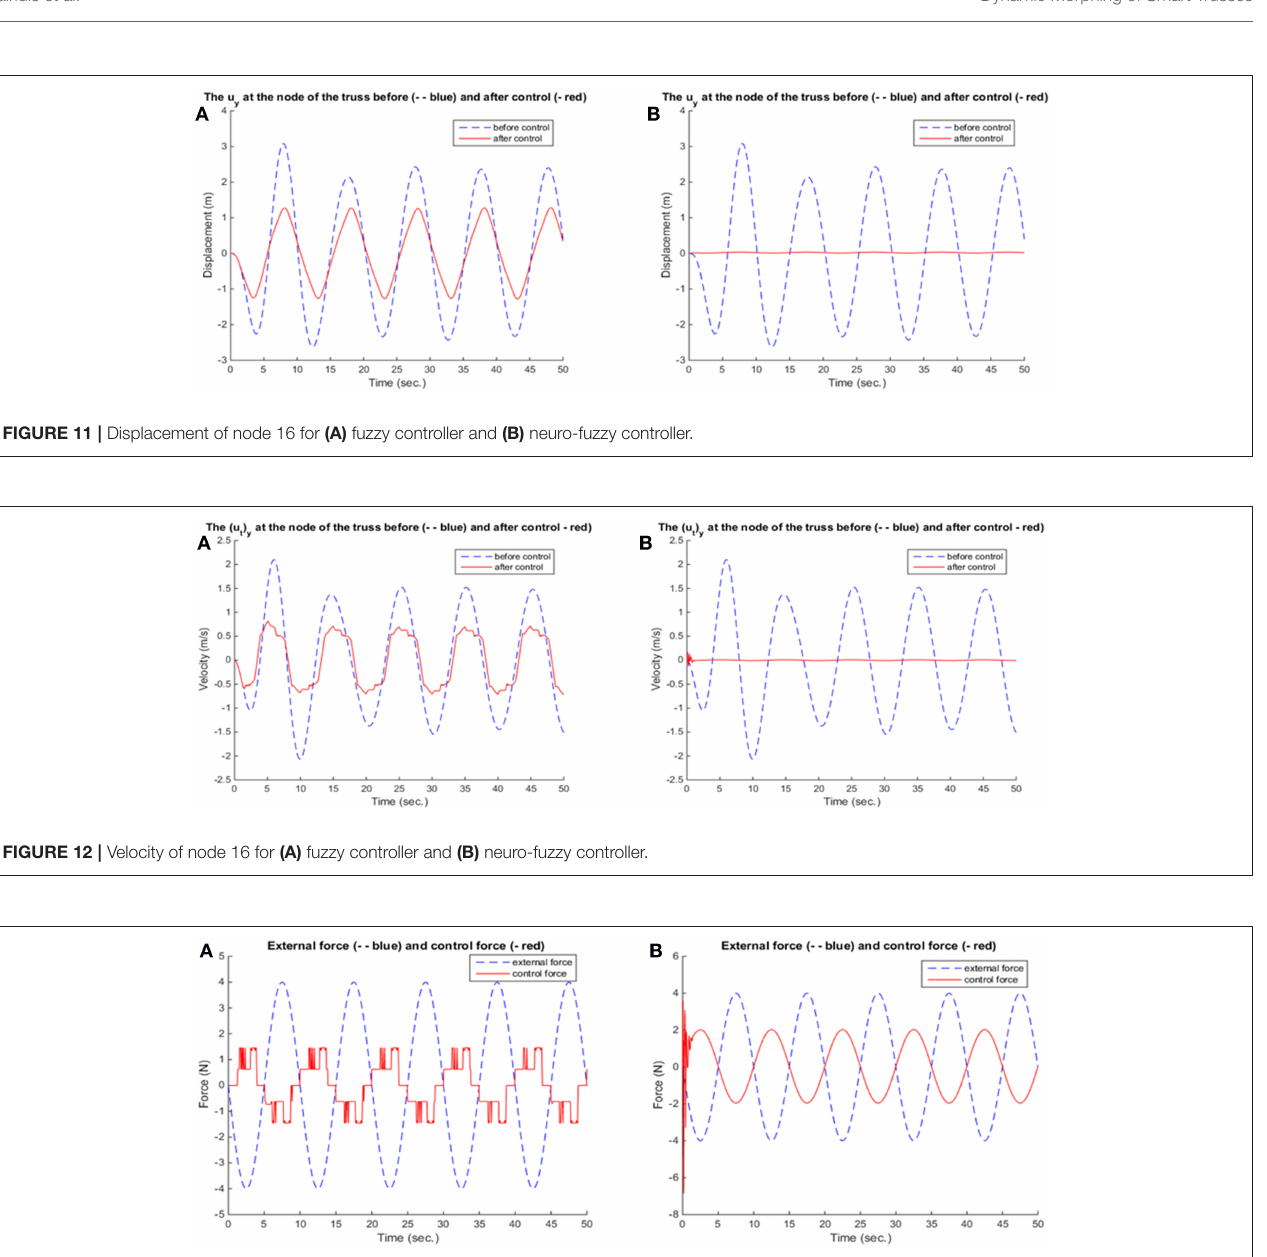
FIGURE 13 | Diagram of forces for (A) fuzzy controller and (B) neuro-fuzzy